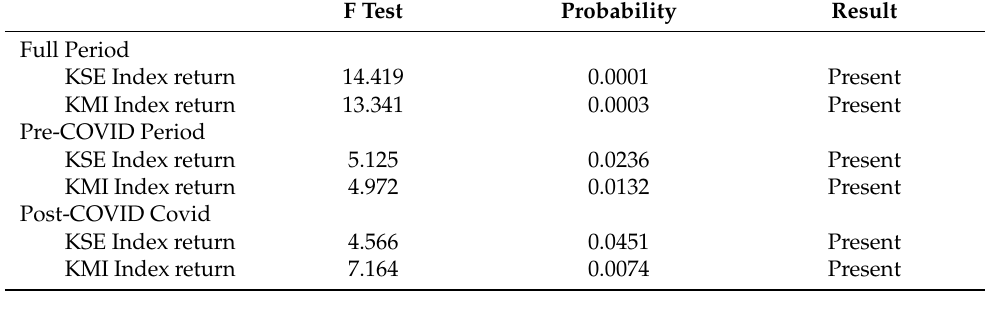
Table 2. ARCH Effect of the three periods.